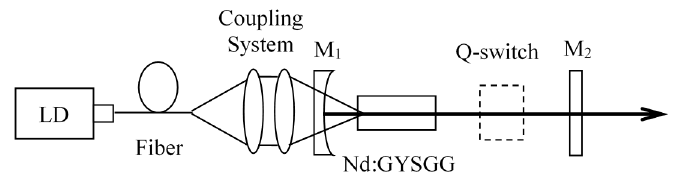
Figure 4. Experimental scheme of the diode-end-pumped Nd:GYSGG laser. LD: diode laser.